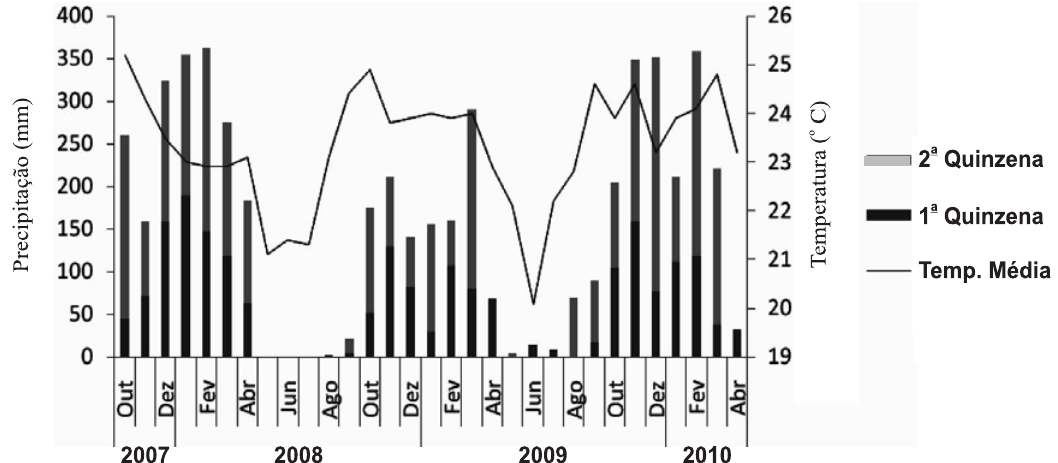
Figura 1. Precipitação pluvial e temperatura média ocorrida em Rio Verde (GO), durante a condução do